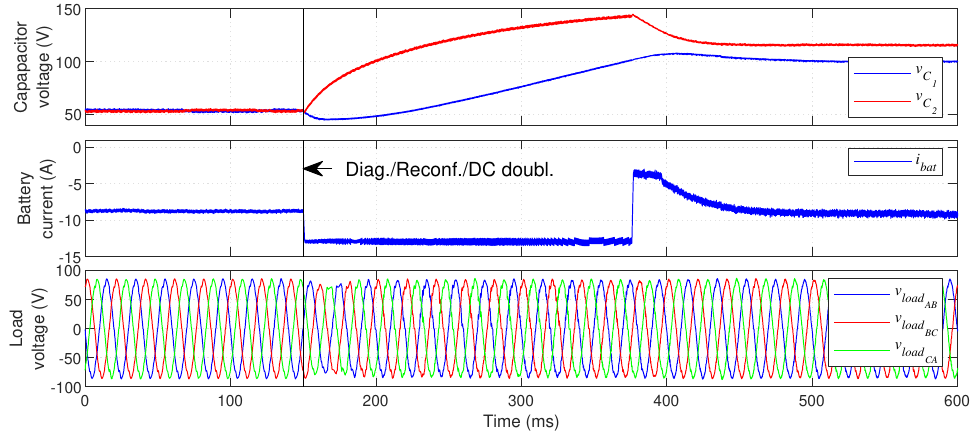
Figure 25. Normal and fault-tolerant UPS operation when an OC occurs in inner IGBT S D 2 of the